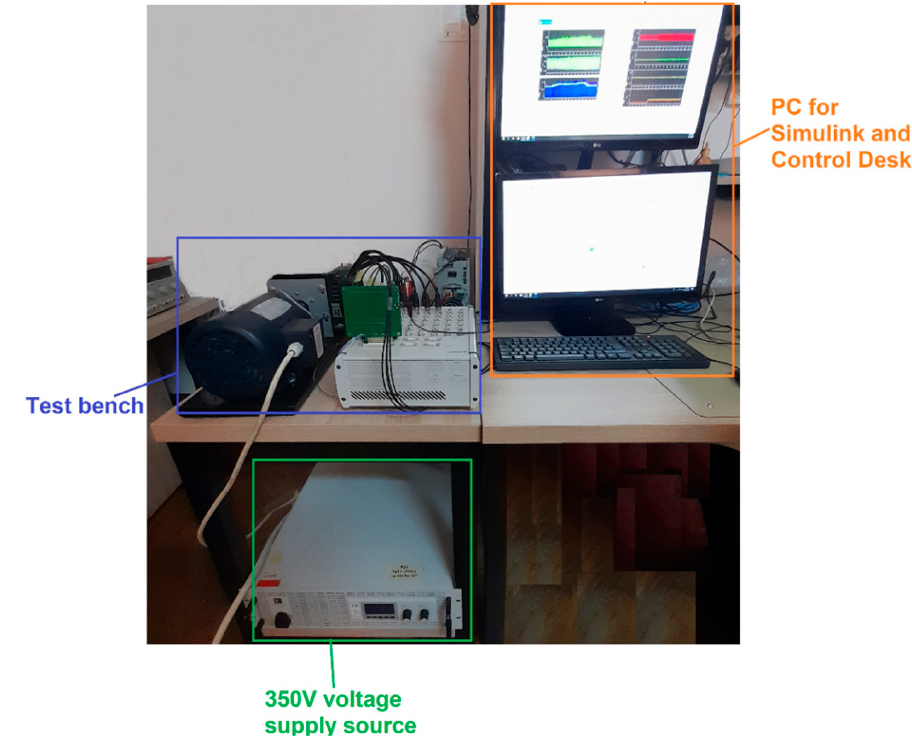
Figure 14. Experimental system .